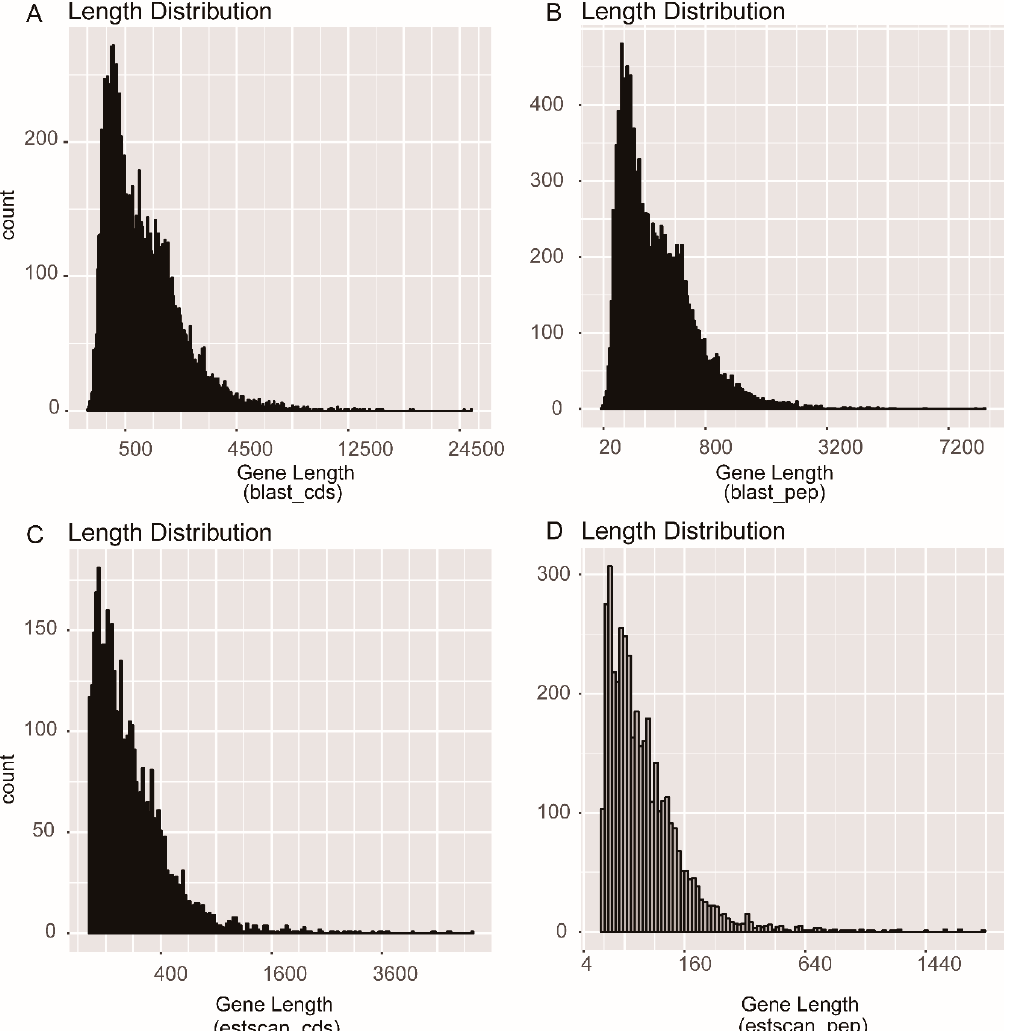
Figure 2. Coding sequence predictions of Donacia provosti transcriptome by BLASTx and ESTScan. Length distribution of ( A ) CDS using BLASTx (E-value < 1e − 5 ), ( B ) proteins using BLASTx, ( C ) CDS predicted by ESTScan, and ( D ) proteins using ESTScan.